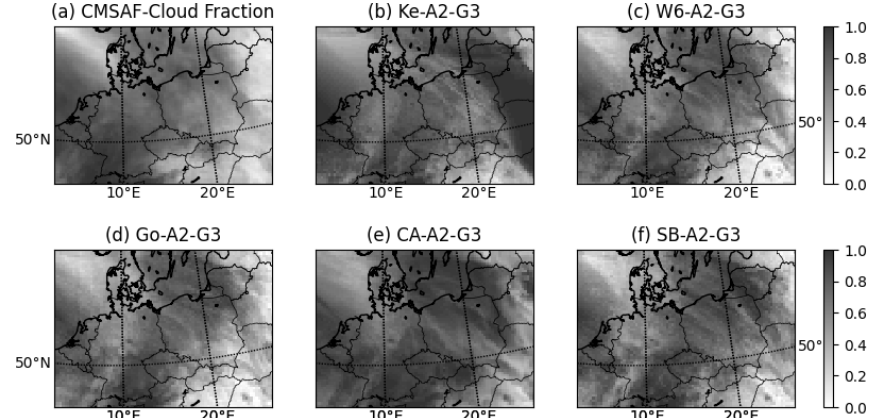
Figure 9. Average cloud cover fraction for 36h of (a) satellite data and simulation by different microphysics, including (b) Kessler, (c) WSM6, (d) Goddard (e) CAM5.1, and (f) SBU–YLin. All simulations are configured with Grell-3D and ACM2 PBL physics, which per- formed a more skilled prediction than any other combination from 23 August.